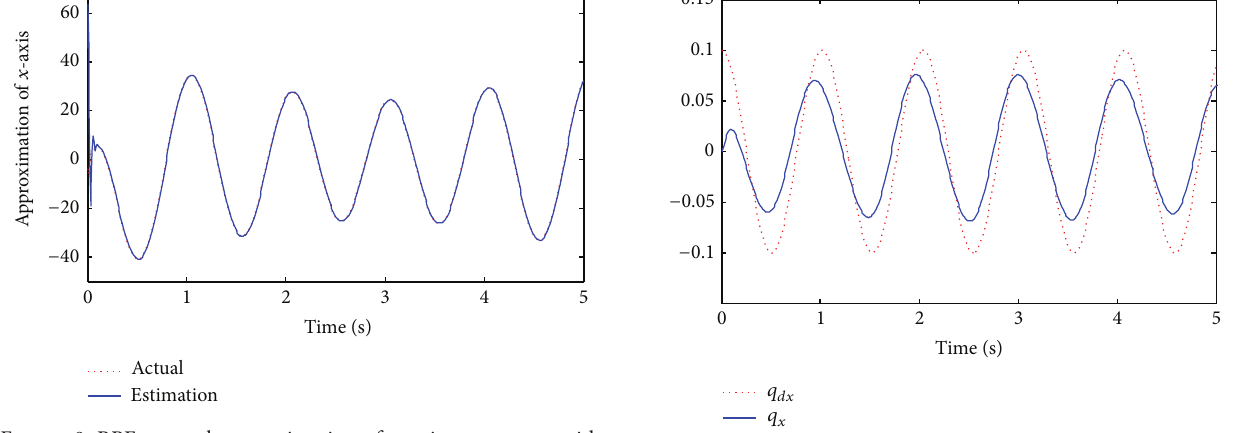
Figure 10: Position tracking of 𝑥 -axis without NN controller.